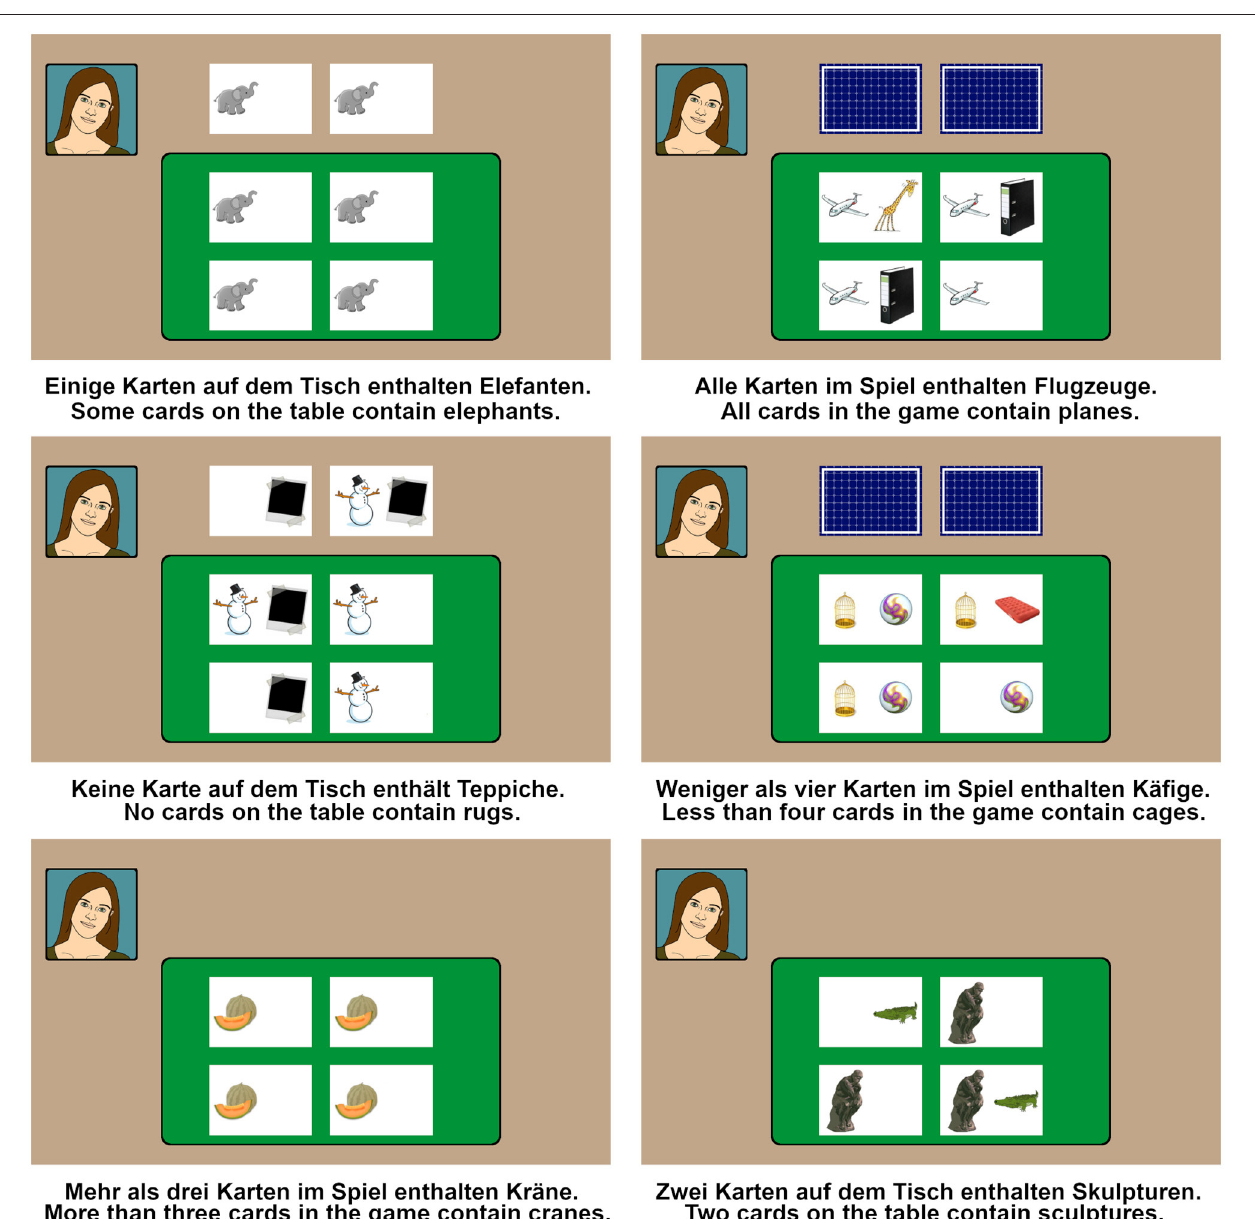
FIGURE 2 | Six example filler trials of various sorts. For each quantifier all three card configurations (closed/open/no additional cards) were used. The number of visible object categories 1–3 was counterbalanced per quantifier/context/card configuration. The two contexts (Table/Game) were cross-balanced for each filler category. Sentences with bare numerals are subject to similar pragmatic ambiguity as those with some , i.e., based on the so-called exactly vs. at least readings. Since all target trials with some always showed two additional cards face-down, we introduced more fillers with two closed cards than those with other card configurations, so that the ratio of trials with closed/open/no additional cards would be relatively balanced across